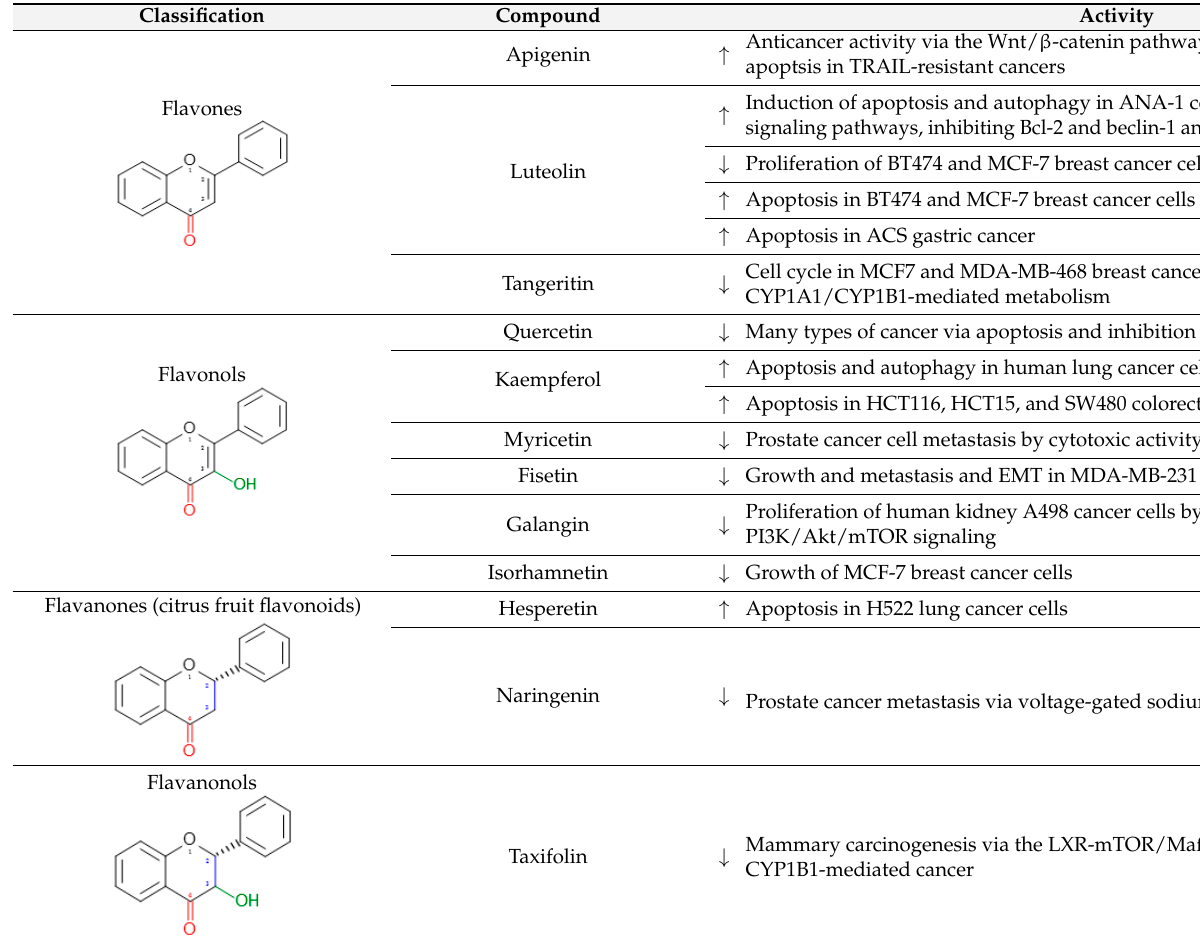
Table 1. Some of the very recent examples of the roles exerted by flavonoids in cancer cells.